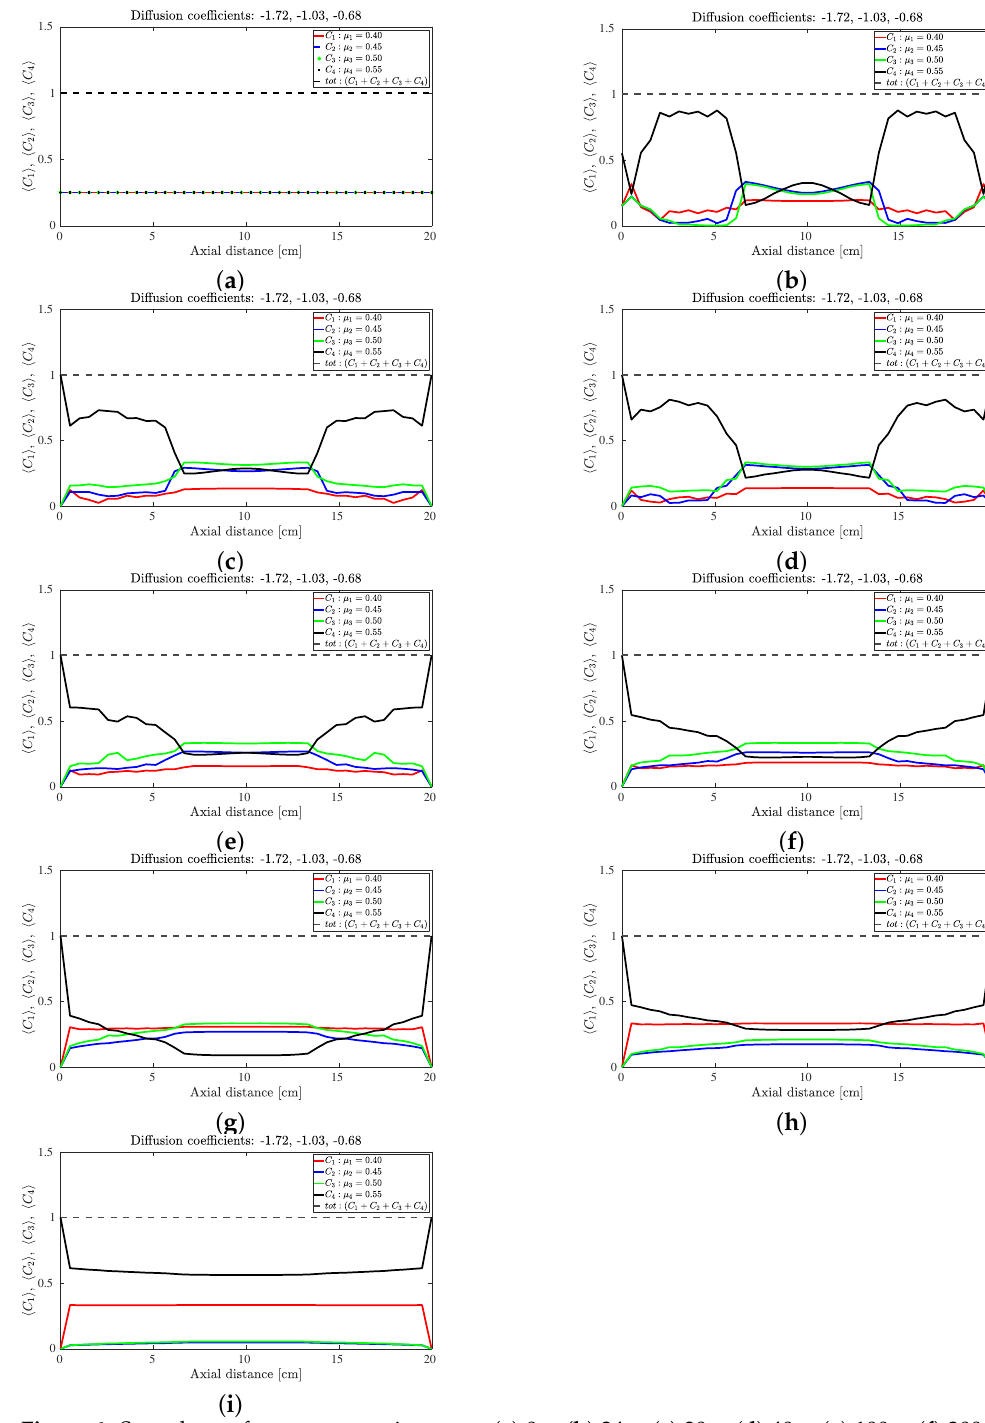
Figure 6. Snapshots of quaternary mixture at: ( a ) 0 s, ( b ) 24 s, ( c ) 30, s ( d ) 40 s, ( e ) 100 s, ( f ) 200 s, ( g ) 500 s, ( h ) 1000 s and ( i ) 5000 s. The corresponding diffusion coefficients are − 1.74, − 1.02 and −